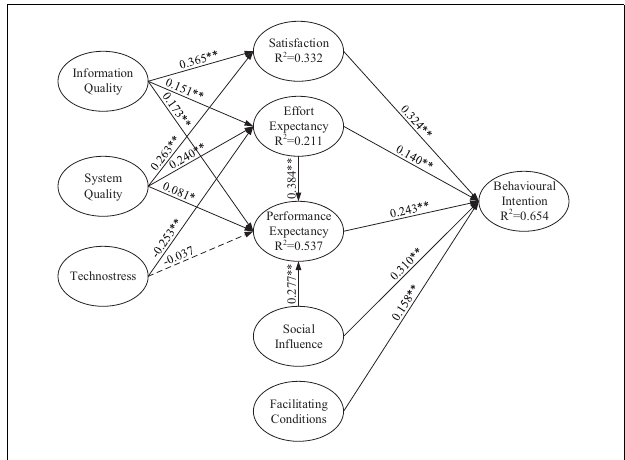
FIGURE 2 | Extended UTAUT with latent variables and path coefficients. Value on path: standardized coefficients ( β ), R 2 : Coefficient of determination and ∗ p < 0.05, ∗∗ p <